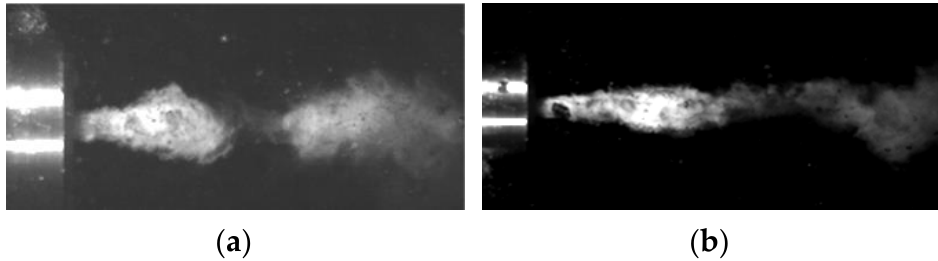
Figure 15. Results of the formation of hydrodynamic impulses in the water stream during the operation of the head in the water environment, at the input pressure: ( a ) 10 MPa, ( b ) 25 MPa. Thanks to the recorded images, it was possible to determine the distance of the formation of hydrodynamic pulses from the outlet from the nozzle of the self-excited pulsed head for drilling holes (Figure 16). It was found that in the tested range, with increasing pressure, such pulses are shaped farther and farther away from the outlet nozzle. The summary of the average distance from the tested material for the head operating in the water environment is presented in Table 7.